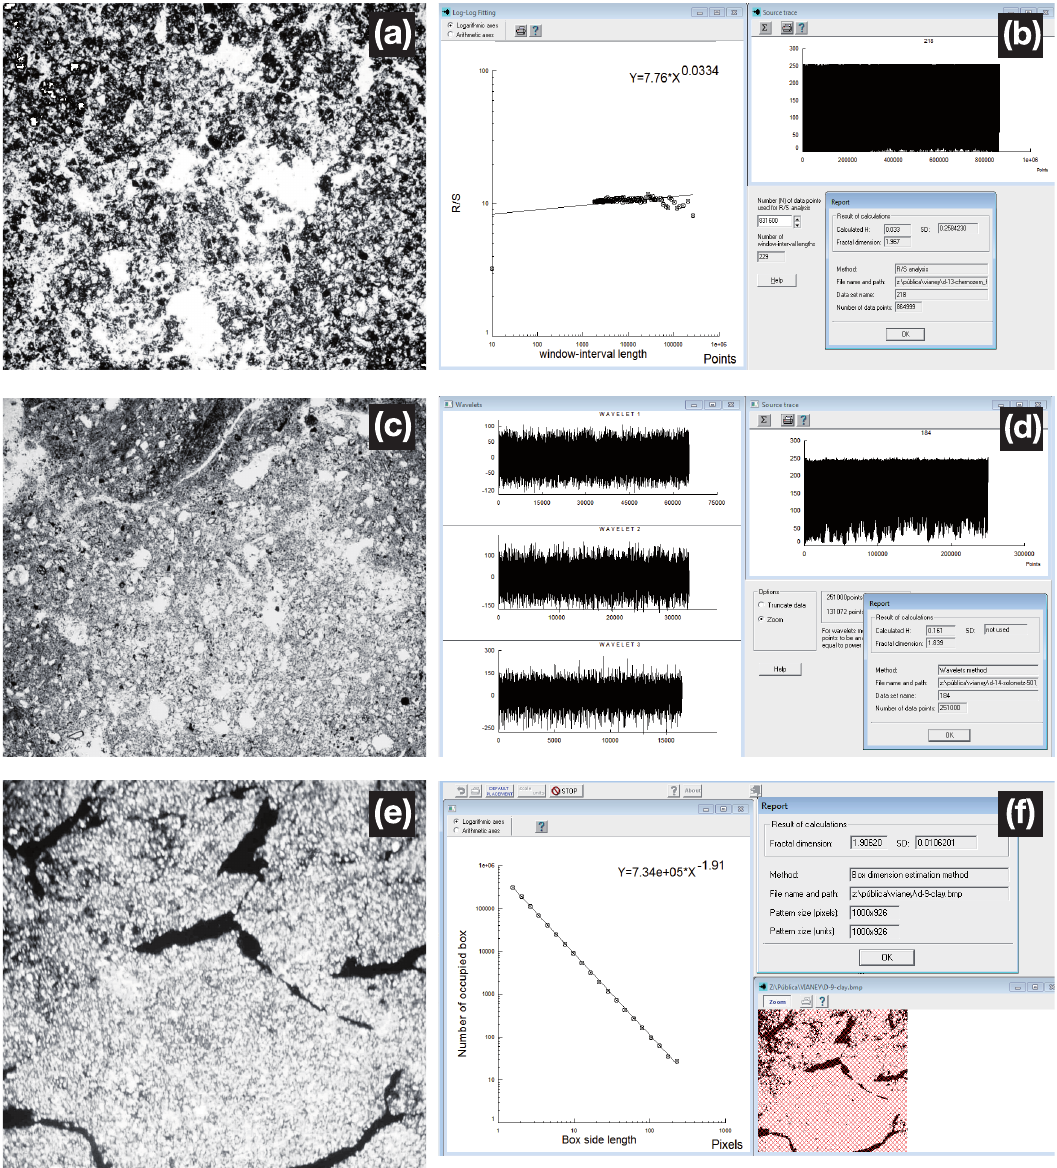
Fig. 3. Benoit’ (Version 1.3) outputs of the compared methods: R / S analysis (b) , wavelets (d) and box counting (f) applied to images of the Chernozem (a) , Solonetz (c) and Clay (e) visualizing the details of each